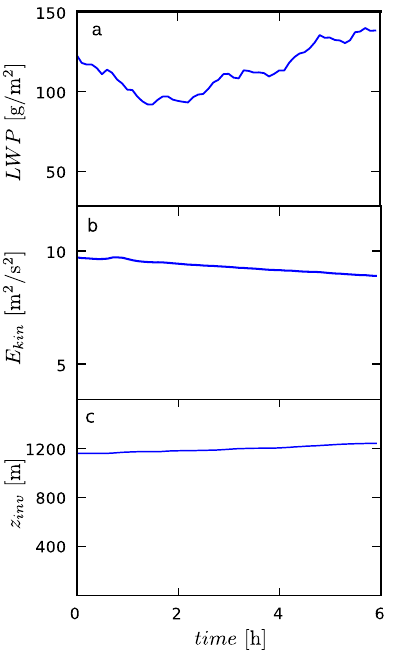
Fig. 6. Evolution of the selected bulk properties of the STBL for the entire length of the simulation. (a) Liquid water path (LWP); (b) resolved kinetic energy per unit of mass E kin ; (c) height of the inversion z inv